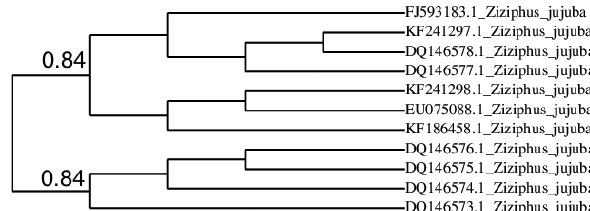
Figure 6. Maximum parsimony phylogenetic tree of jujube cultivars based on ITS sequences (Numbers above branches are bootstrap value).